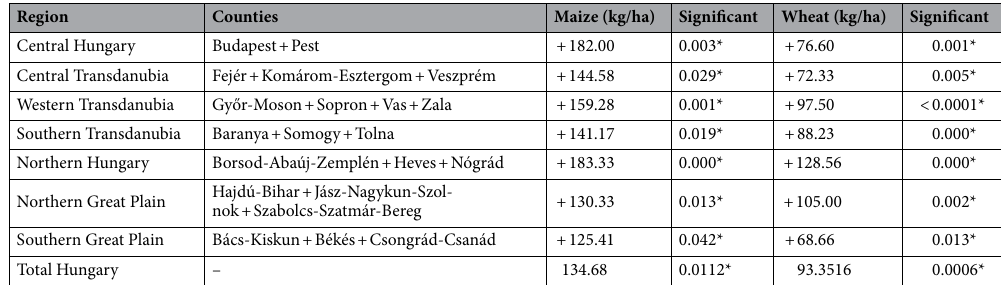
Table 5. Trend (MK t) and Sen’s slope of maize and wheat yields across Hungarian regions between 2000 and 2020. *Significant p < 0.05.